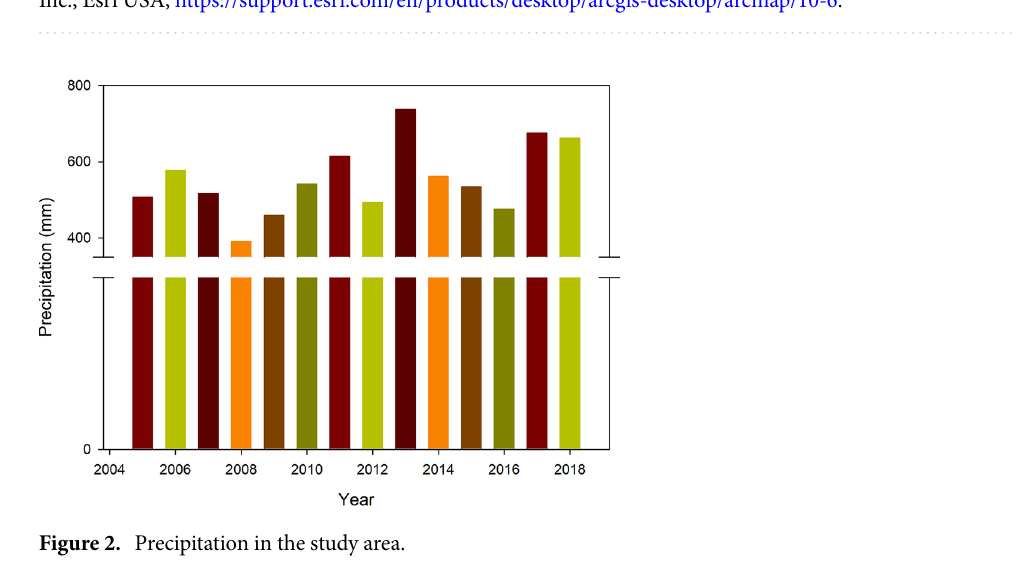
Figure 1. Land use map in the study area. It was created using ArcGIS version 10.6, from ArcGIS Software, Inc., Esri USA, https:// suppo rt. esri. com/ en/ produ cts/ deskt op/ arcgis- deskt op/ arcmap/ 10-6.